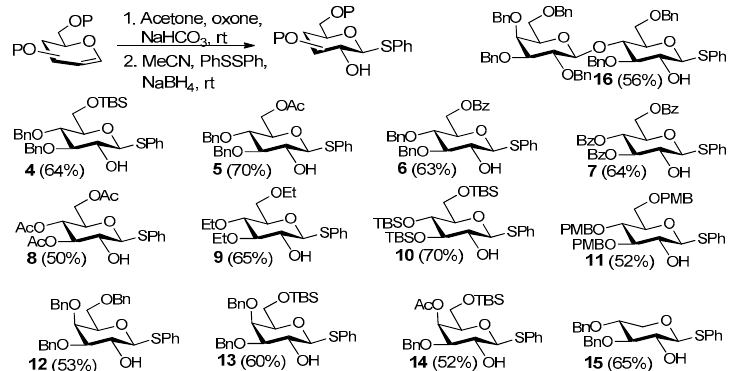
Figure 4. Synthesis of 1-thiophenyl glycosides with 2-OH starting from corresponding glycals.